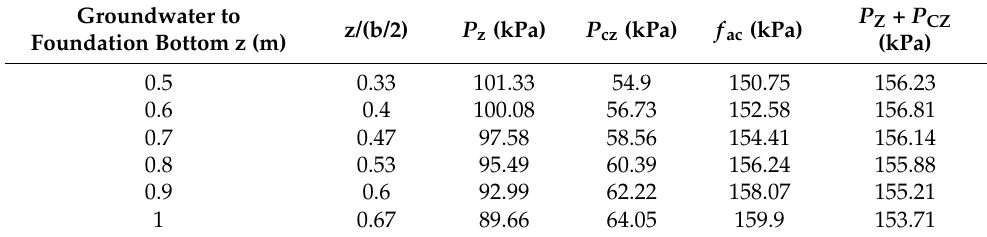
Table 9. Calculation results of foundation bearing capacity (b = 3 m, d = 2.5